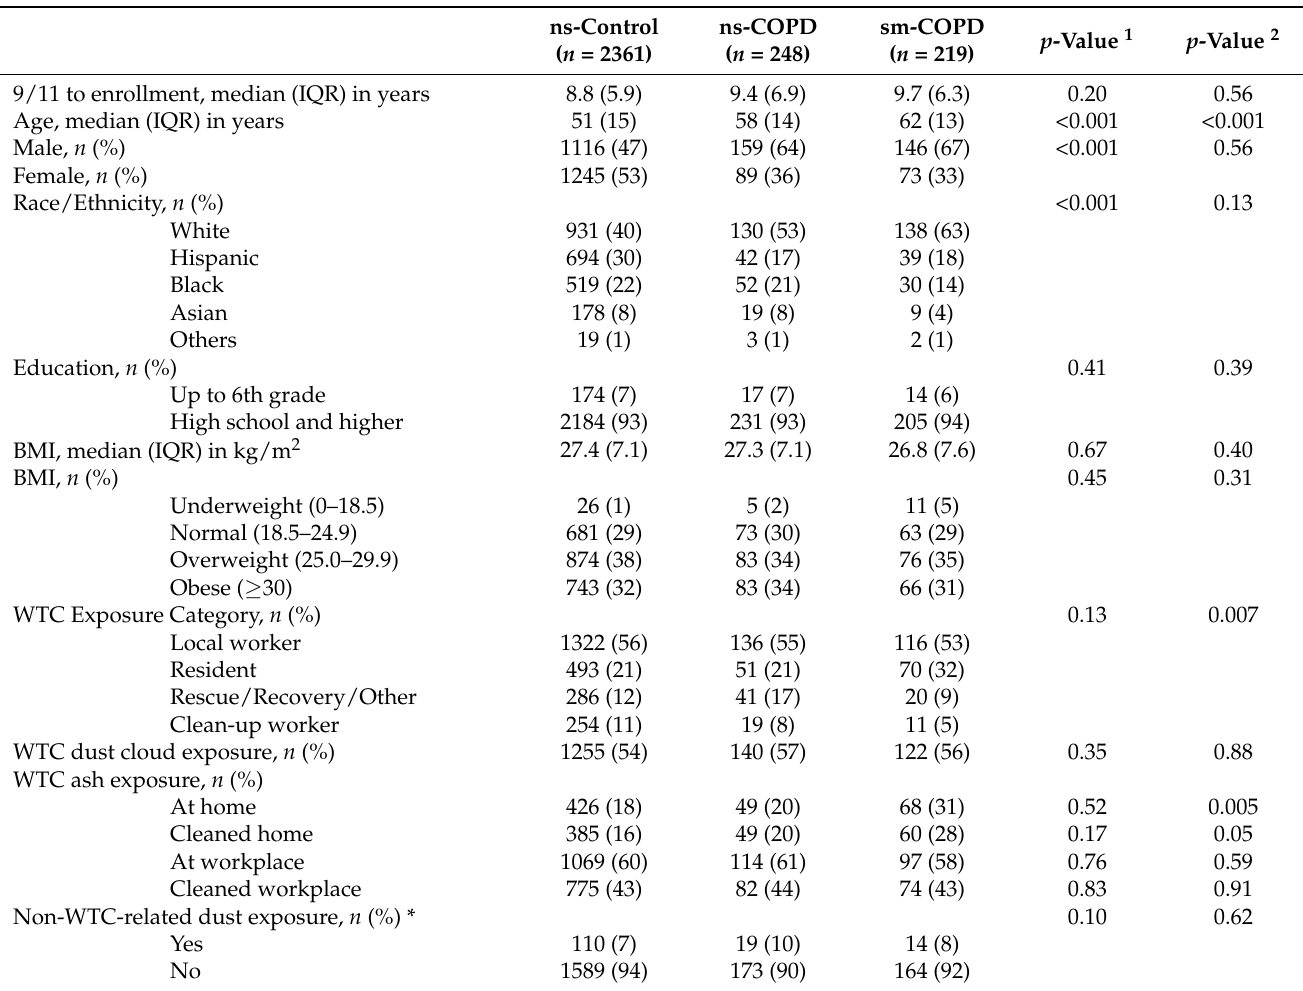
Table 1. Characteristics of patients in the WTC